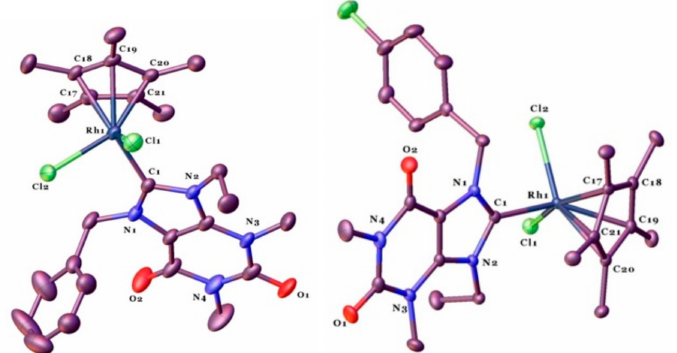
Figure 6. Molecular structures of compounds 18 (top) and 19 (bottom). Thermal ellipsoids are drawn at the 50% level. Hydrogen atoms have been omitted for clarity.